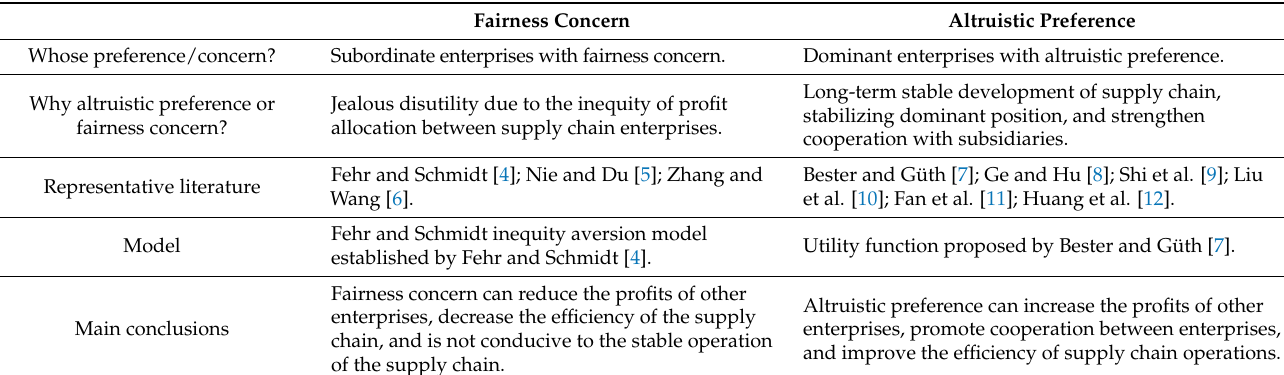
Table 1. Differences between fairness concern and altruistic